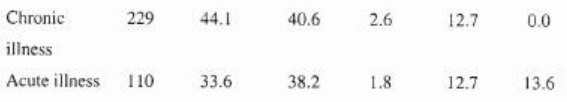
‘Table 4.Distribution of respondents according to